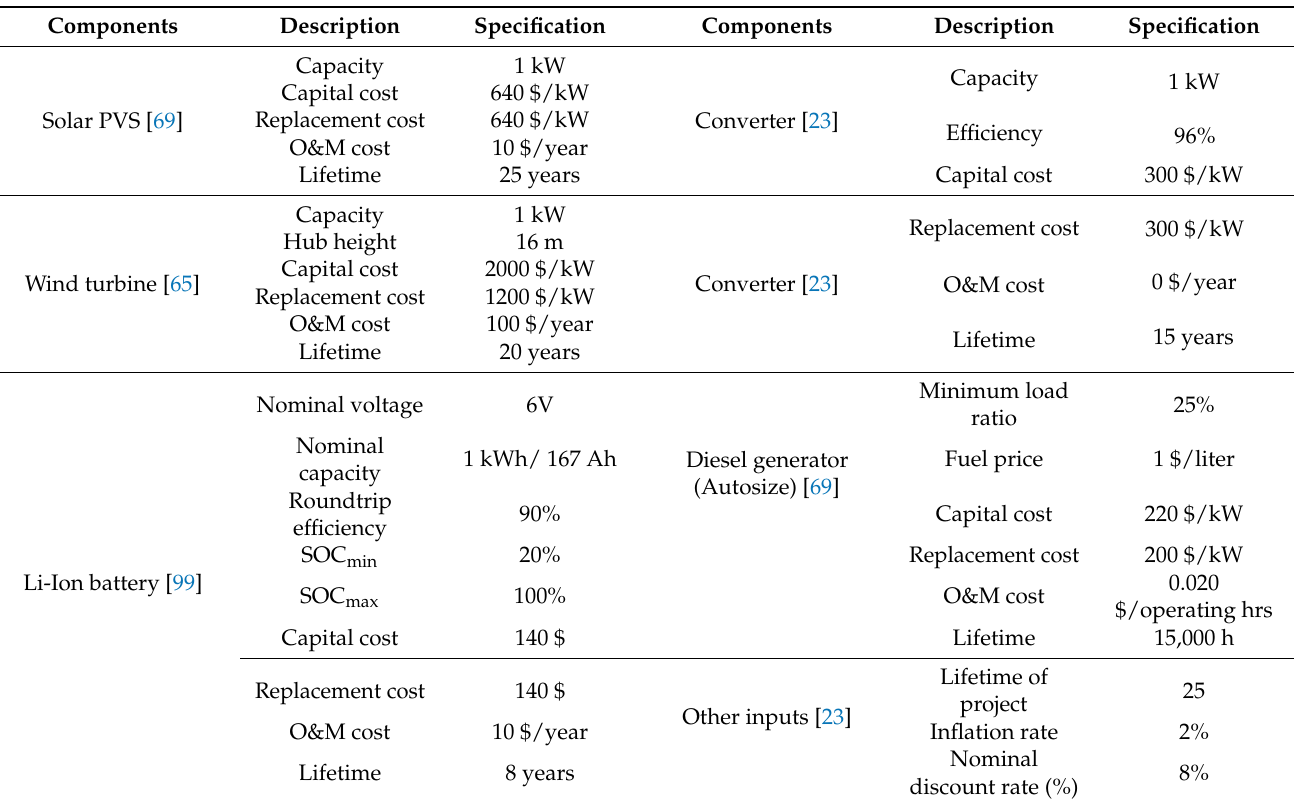
Table 4. Specification of the hybrid